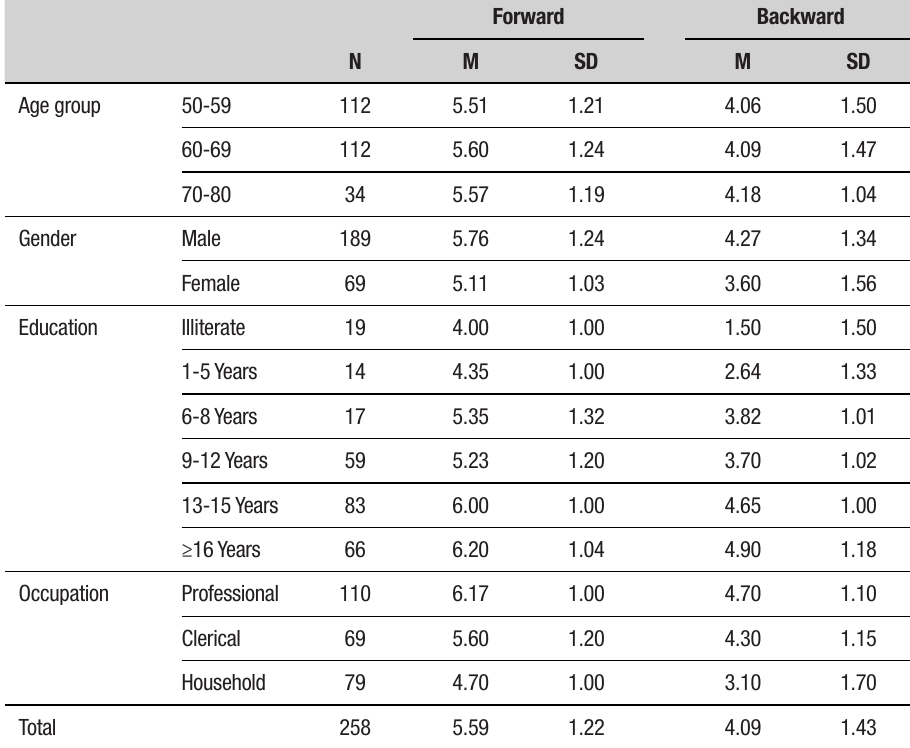
Table 1. Demographic data of the participants, with means and standard deviations.